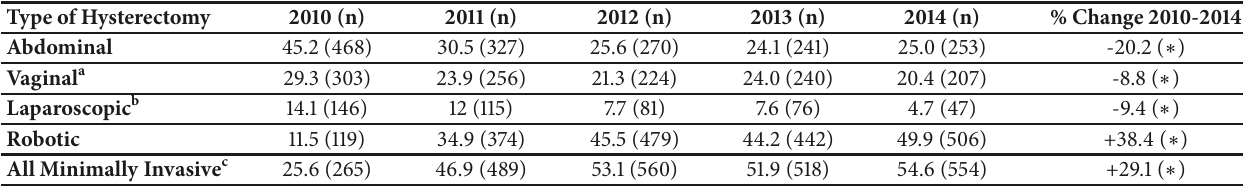
Table 2: Percent of hysterectomies by route-both hospitals.